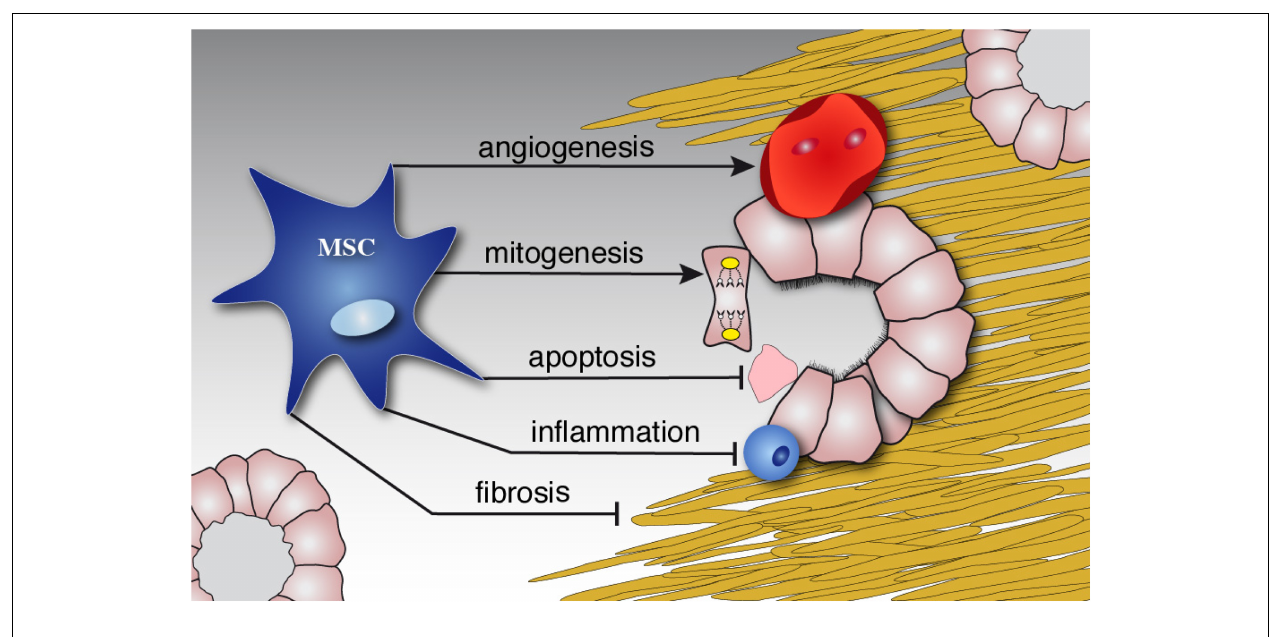
FIGURE 2 | MSCs diminish damage and induce repair. Schematic illustration of the paracrine effects of MSCs on the kidney.While stimulating